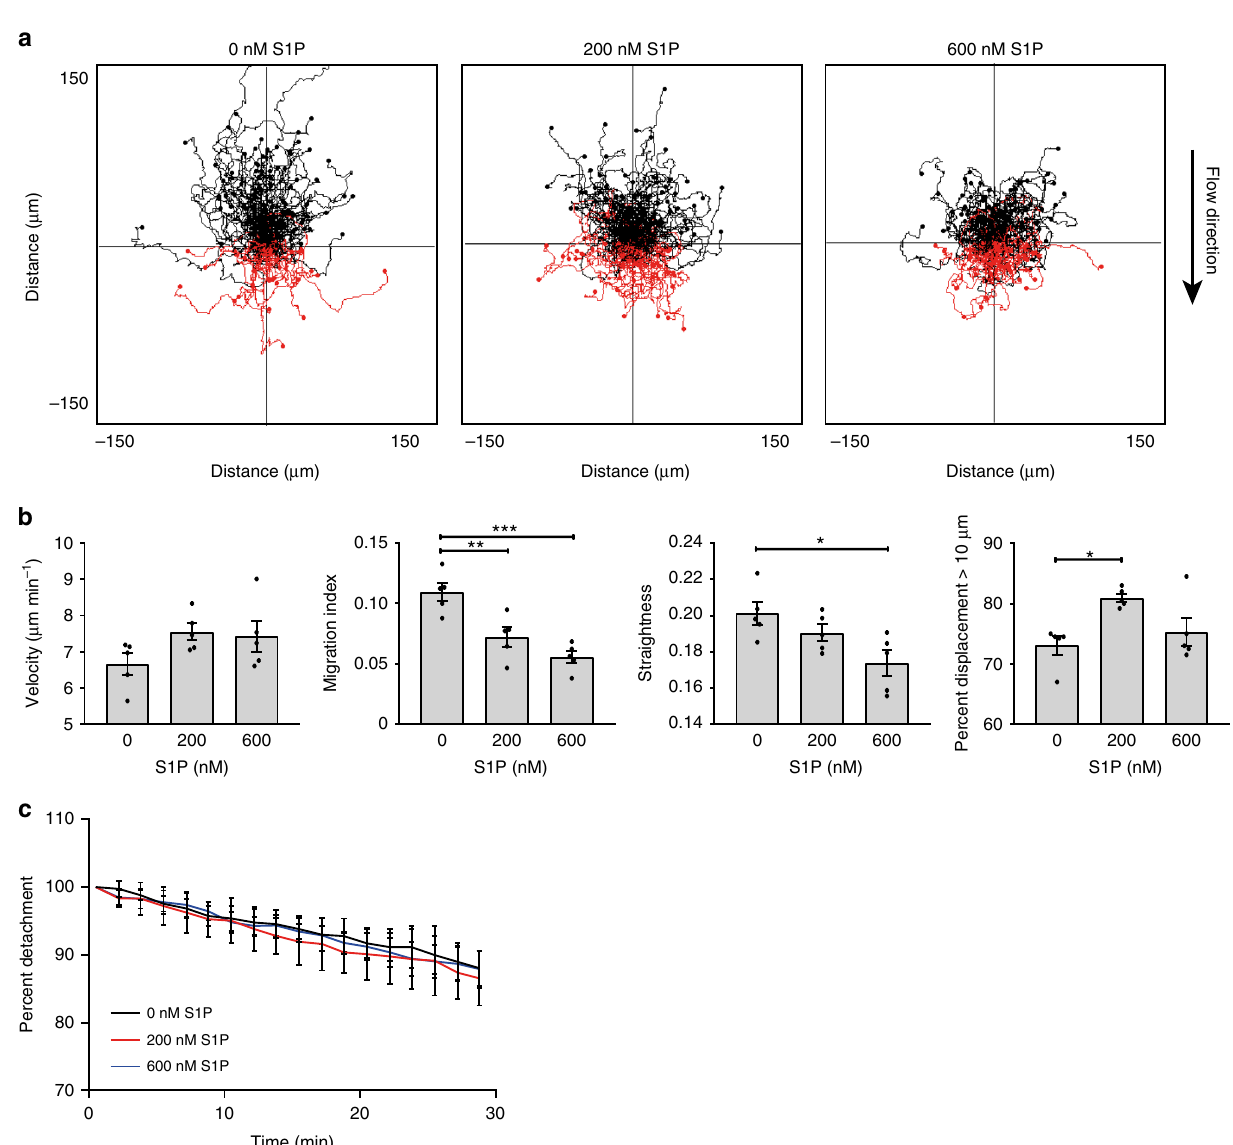
Fig. 5 S1P inhibits MZB from migrating up shear fl ow. a Representative track plots of MZB migrating under fl ow (3 dyn cm − 2 ) on ICAM-1 (5 µ g ml − 1 ) treated during migration with 0, 200, or 600 nM of S1P. b Quanti fi cation of velocity, migration index, straightness, and % of cells that migrated > 10 µ m. All four graphs show different parameters from the same set of experiments; bars show mean ± SEM. Data are from three experiments: two with two mice each and one with one mouse, total fi ve mice per condition. c Detachment of MZB from a calculated as a % relative to the number of cells after the start of fl ow. * P < 0.05, ** P < 0.01, *** P < 0.001, one-way ANOVA with Dunnett post hoc tests comparing S1P at 200 or 600 – 0